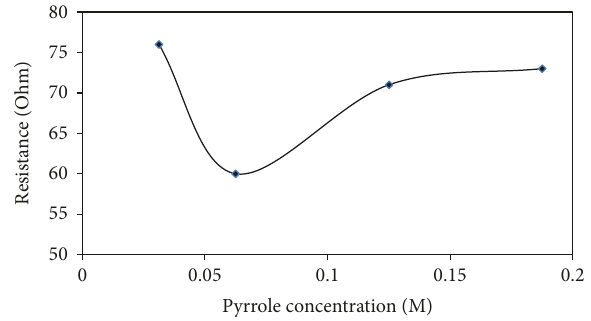
Figure 5: Resistance versus di ff erent pyrrole concentrations (ferric chloride 0.1M at 25 ° C, duration 4 hrs, and surfactant